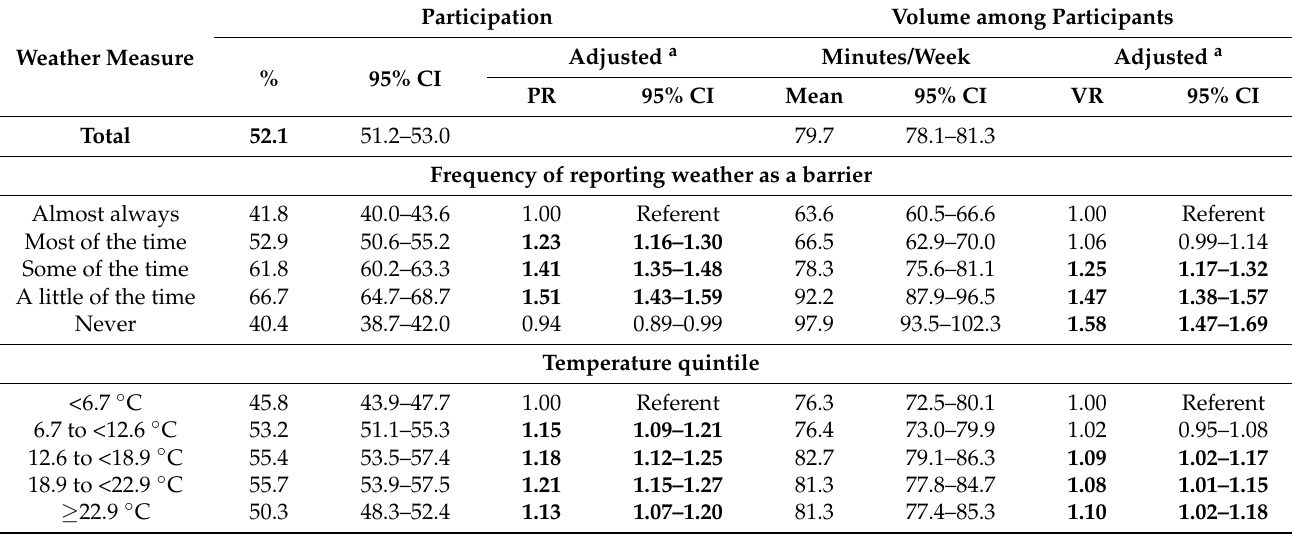
Table 3. Prevalence and volume of leisure walking (among participants) by weather measure.